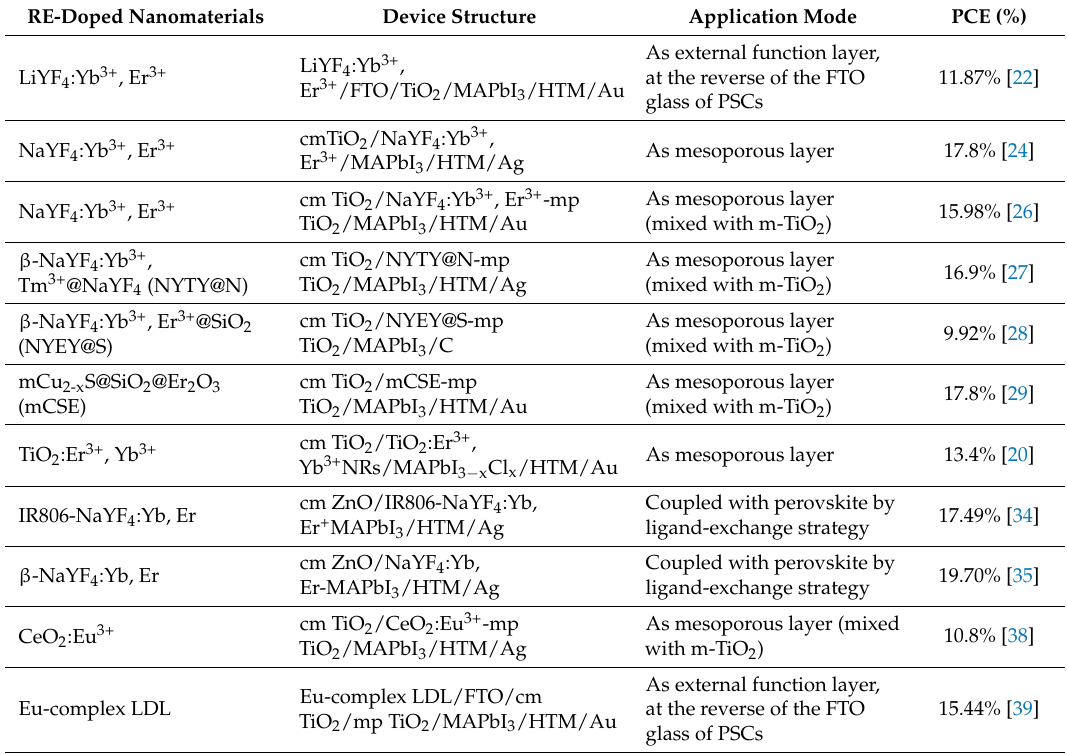
Table 1. Summary of the devices of application of RE-doped nanomaterials in